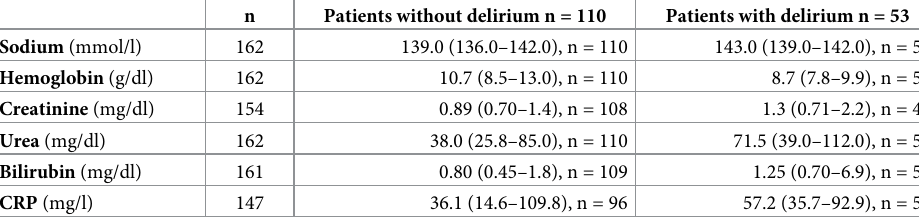
tional normalized ratio) + 6.43